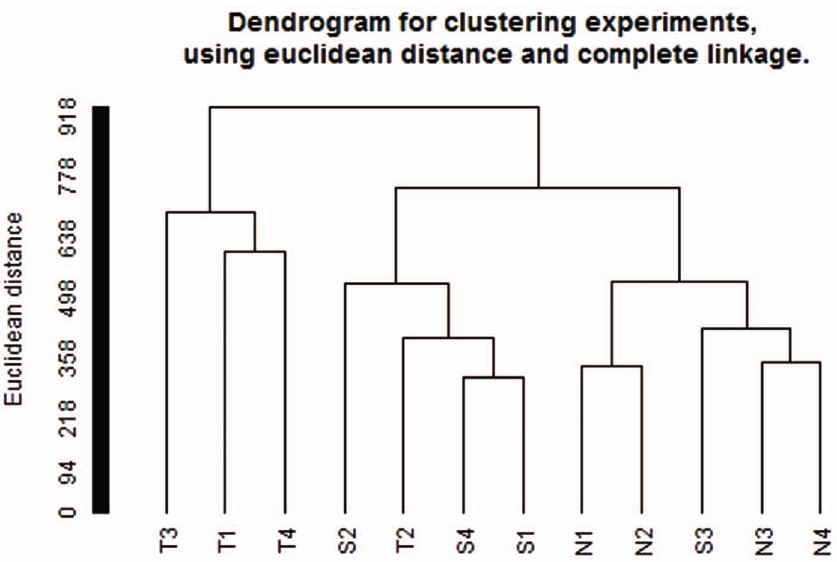
Figure 2. Unsupervised clustering of samples. Unsupervised hierarchical clustering on the entire DNA methylation data set showed the 2 clusters which were mainly composed by two different phenotypes: tumor and normal (including normal and adjcent normal tissues). This indicated that ESCC and normal samples might have different DNA methylation characters and patterns. In addition, there were some differences in DNA methylation profiles between adjacent normal and normal tissues.